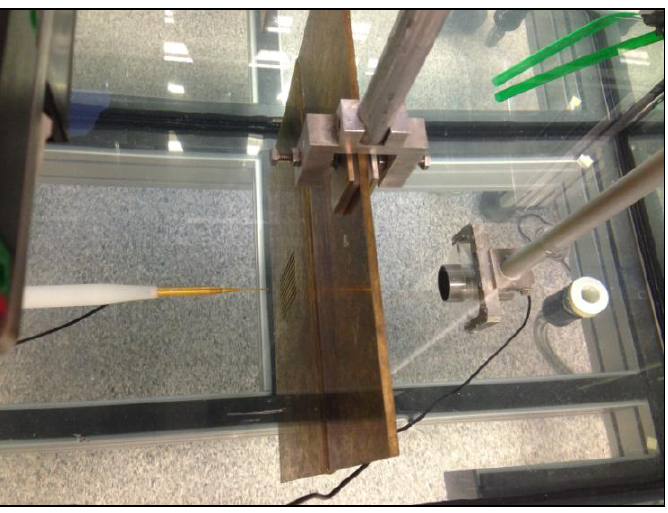
Figure 2. Picture of the experimental